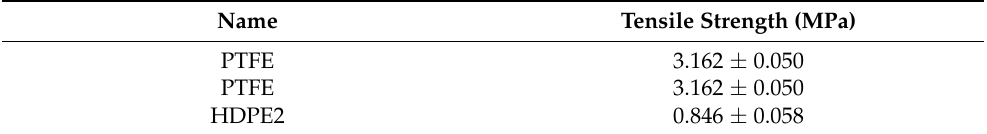
Table 3. Tensile strength of PTFE, HDPE1 and HDPE2 pellets produced using the compaction simulator. Pellets were compacted at 392 MPa. Calculated values are the mean ± one standard deviation ( n =